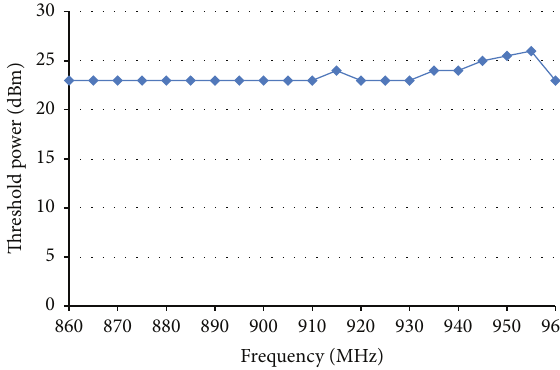
Figure 9: The minimum threshold power to activate the tag chip.